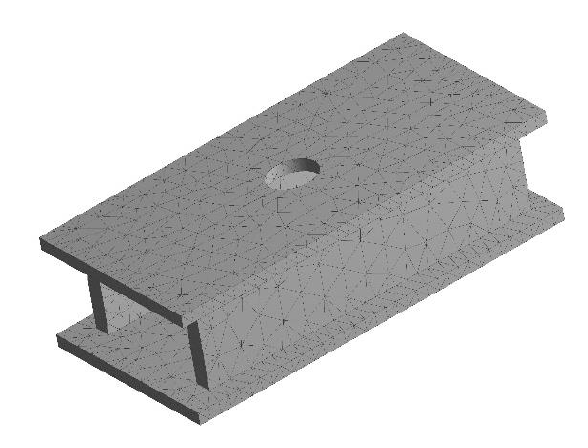
Figure 6. Hull model with